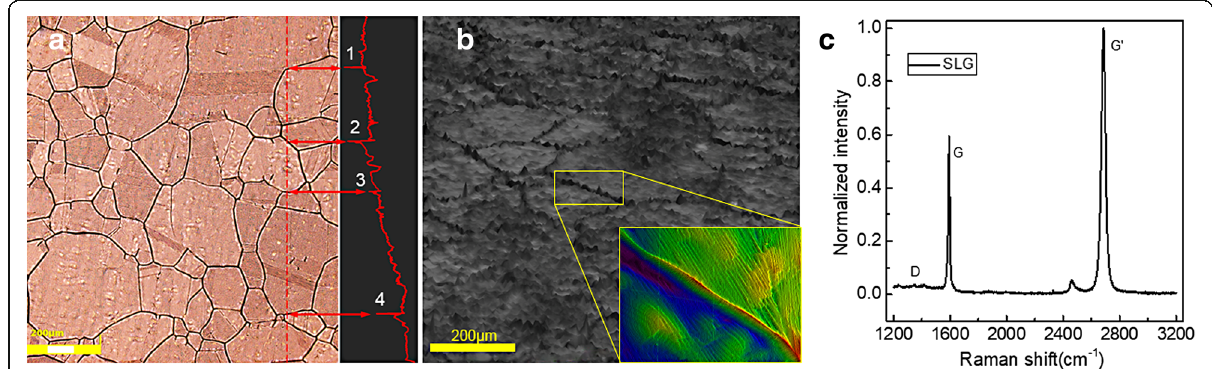
Fig. 2 Three-dimensional laser confocal microscope map of a graphene on Cu foil and b graphene on HRA/PET. c Raman spectra of the graphene transferred from Cu foils onto SiO 2